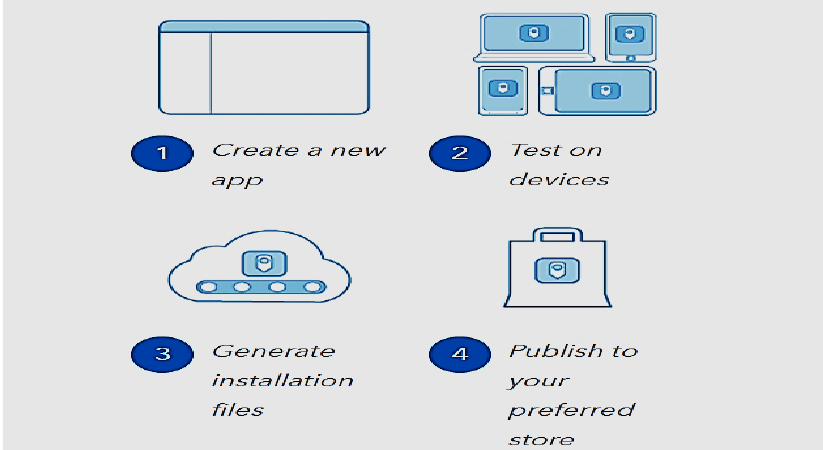
Figure 6. General stages for creating an app in AppStudio.